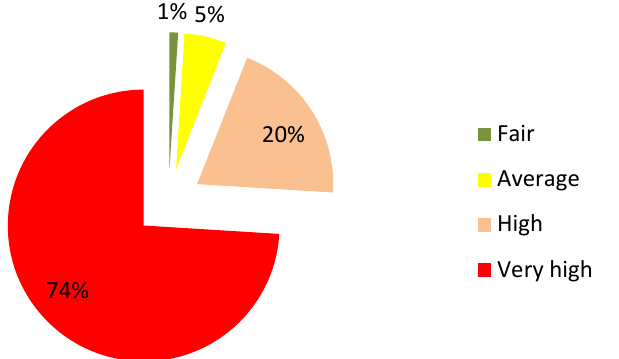
Figure 8. Distribution of vulnerability assessment over the structures studied.